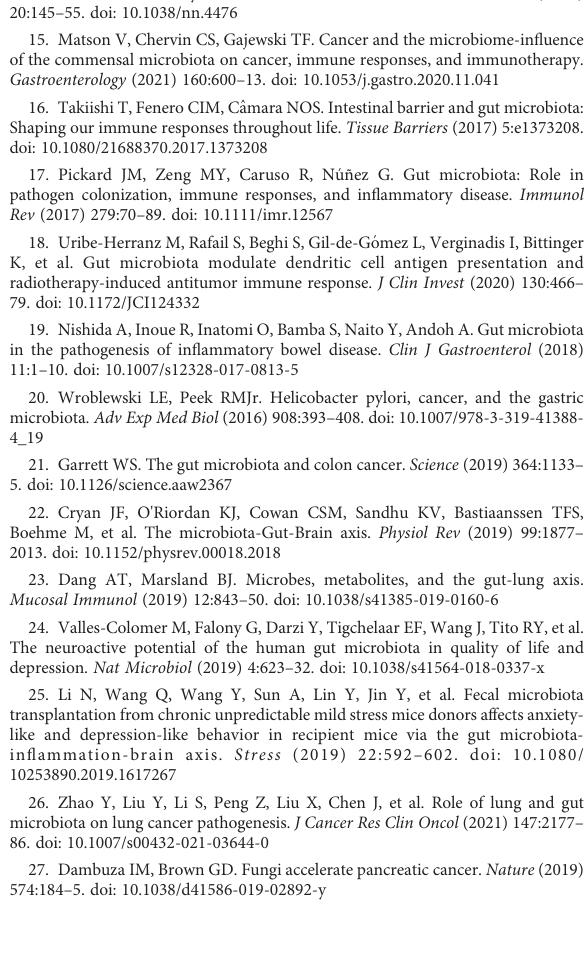
SUPPLEMENTARY FIGURE 1 Heatmap of the correlation between CLRs and multiple cytokines (A) . The abscissa and ordinate represent the genes, respectively. Colors represent different correlation coef fi cients (blue represents positive correlation; red represents negative correlation); the darker the color, the stronger the relation. * p < 0.05, ** p < 0.01. The correlation between the expression of the CLRs and the two key downstream transcription factors: PRDM1 and c-MAF (B)